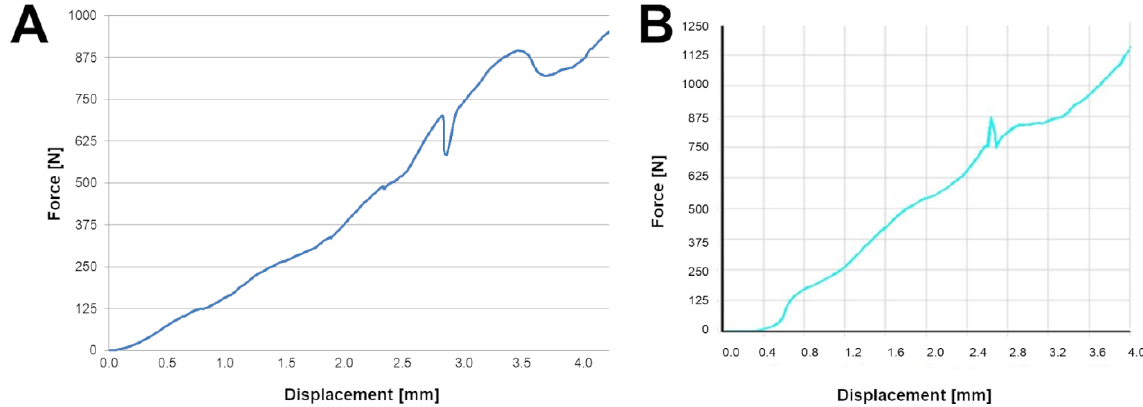
Figure 5. Force — displacement plots obtained during ( A ) experimental compression, ( B ) finite element analysis.